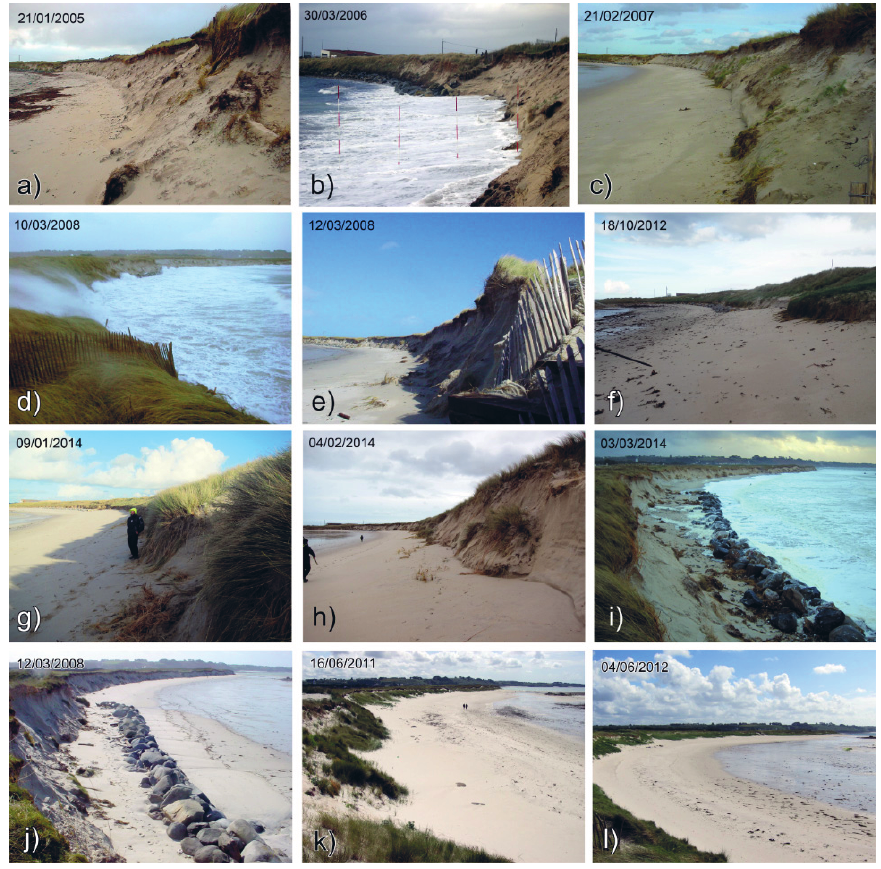
Figure 12. Photos illustrating dune erosion which occurred during the high extreme water levels phases inventoried in Figure 11: ( a ) post-12 January 2005 extreme water level; ( b ) a day before 31 March 2006 extreme water level; ( c ) post-20 February 2007 extreme water level; ( d ) 10 March 2008 storm event; ( e ) post-10 March 2008 storm event; ( f ) post-17 October 2012 extreme water level; ( g ) post-04 January 2014 extreme water level; ( h ) post-02 February 2014 extreme water level; and ( i ) 03 March 2014 storm event. Photos illustrating the dune recover phase post-storm of 10 March 2008 to September 2012 ( j – l